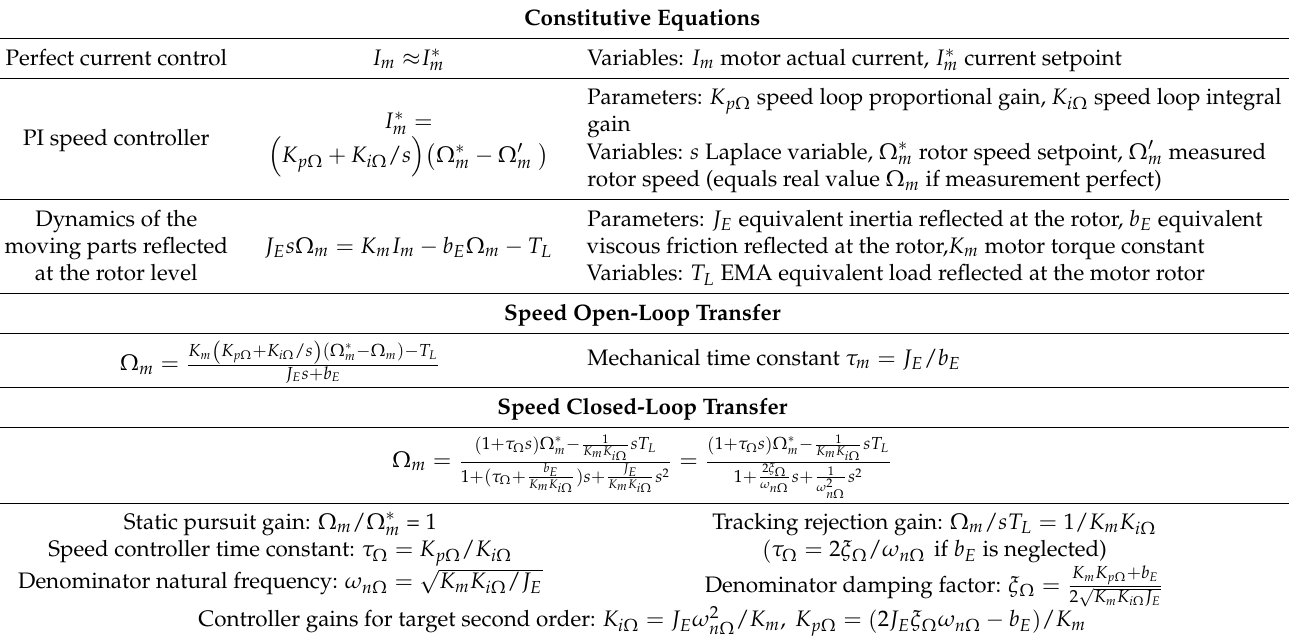
Table A2. Speed loop model and analysis in continuous-time domain. Constitutive